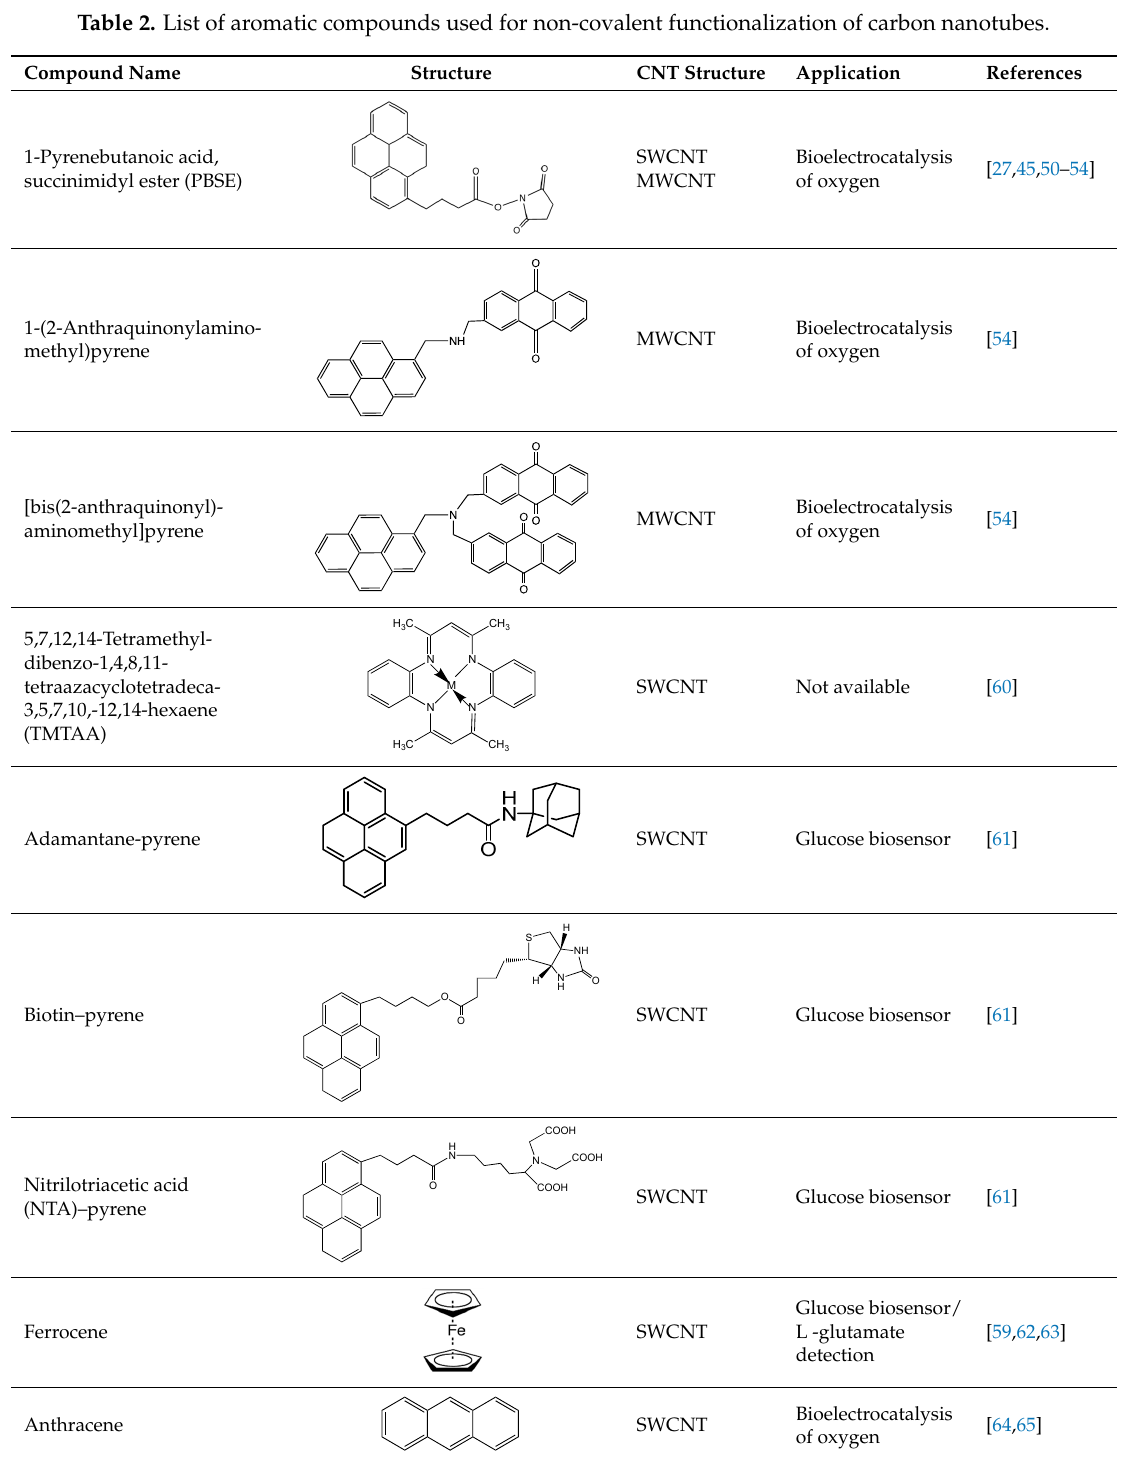
Table 2. List of aromatic compounds used for non-covalent functionalization of carbon nanotubes.